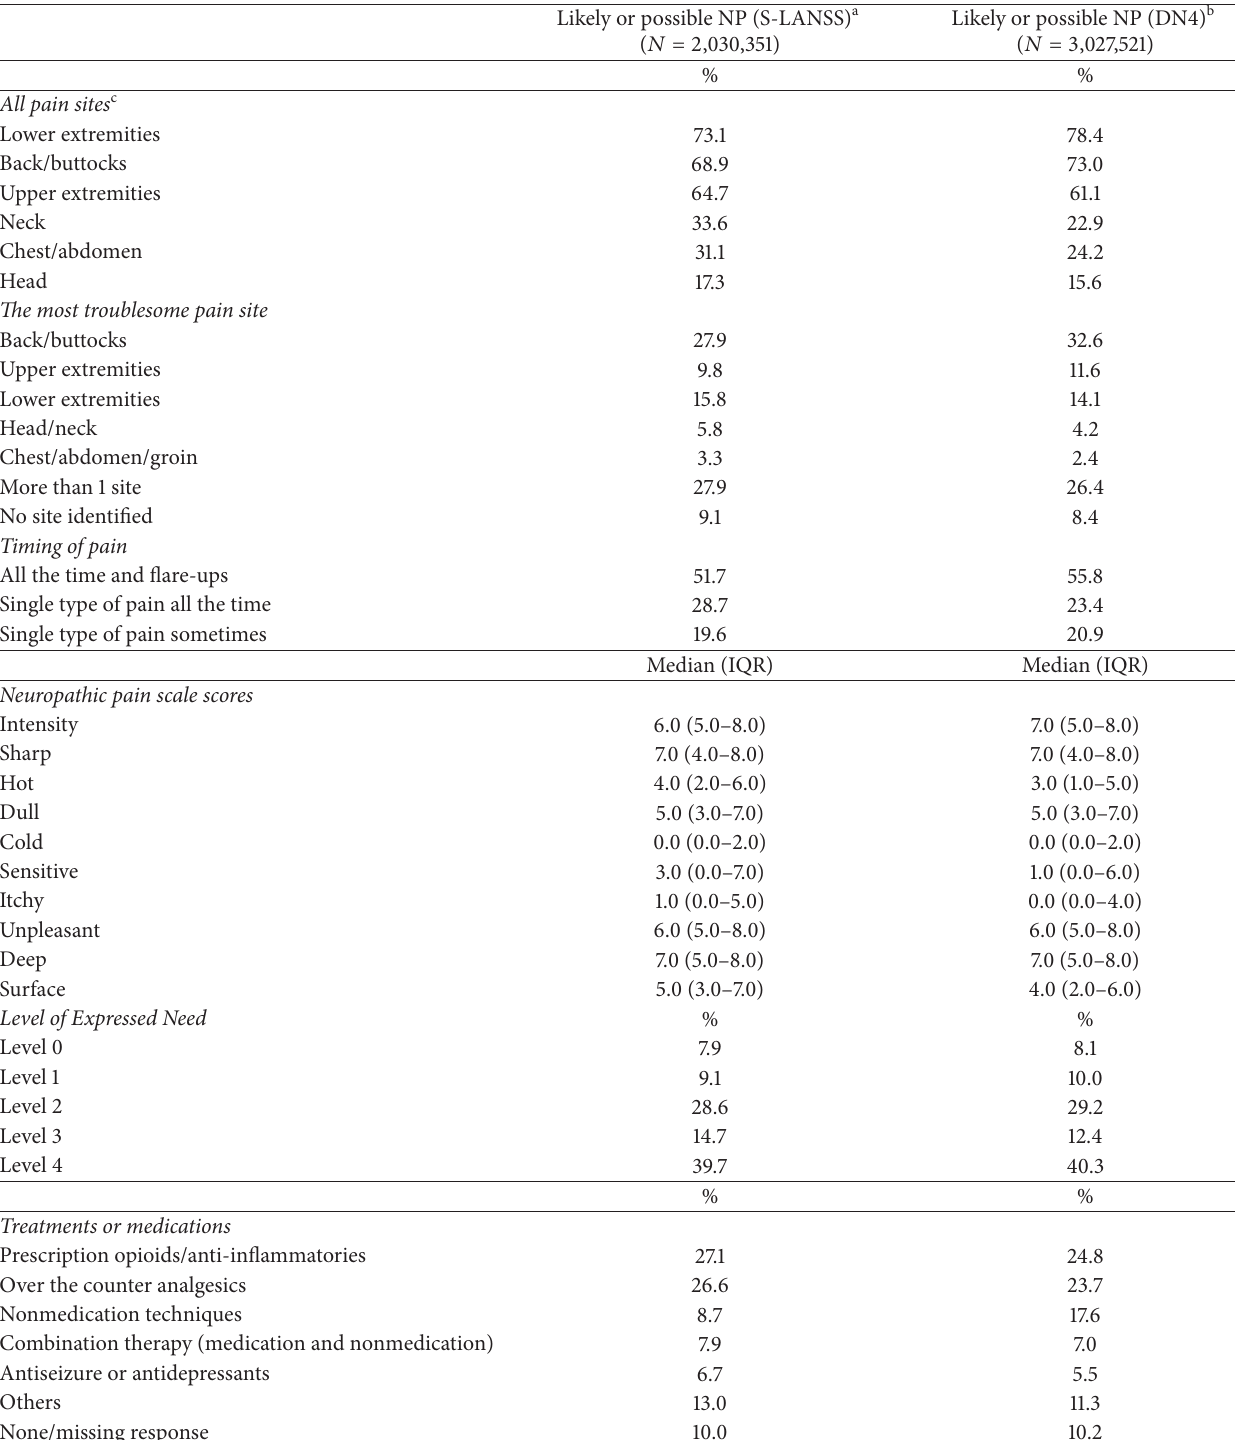
Table 3: Characteristics and management of neuropathic pain (sample weighted to general